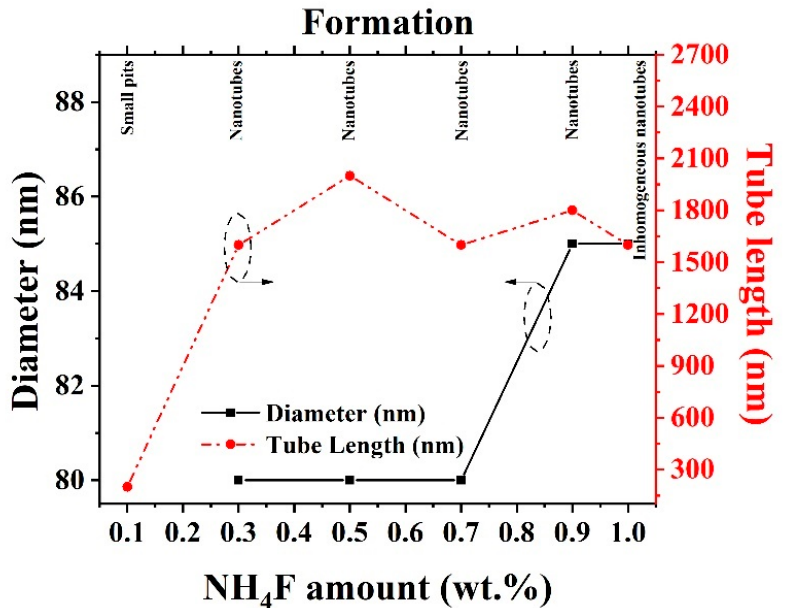
Figure 2. Anodic TiO 2 formed at 20 V for 90 min in the glycerol–water electrolyte with different NH 4 F concentrations: 0.1, 0.3, 0.5, 0.7, 0.9, and 1.0